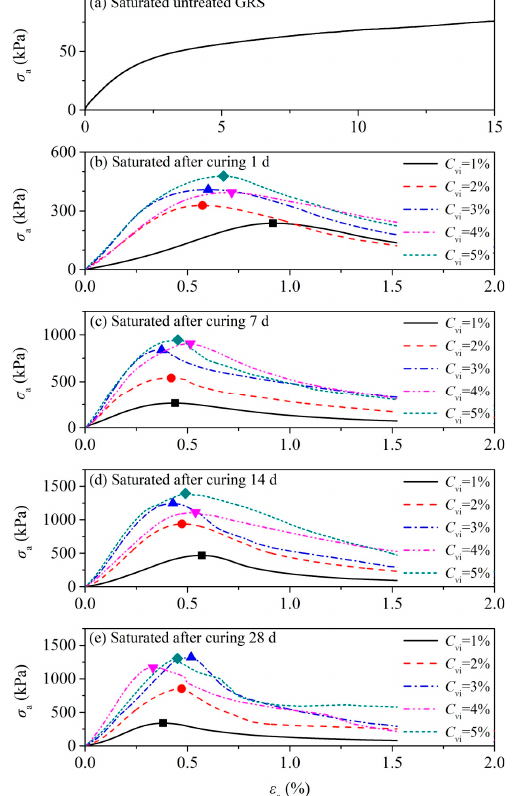
Figure 6. Stress–strain curves of saturated untreated and cement-treated GRSs at various cement contents and curing times.